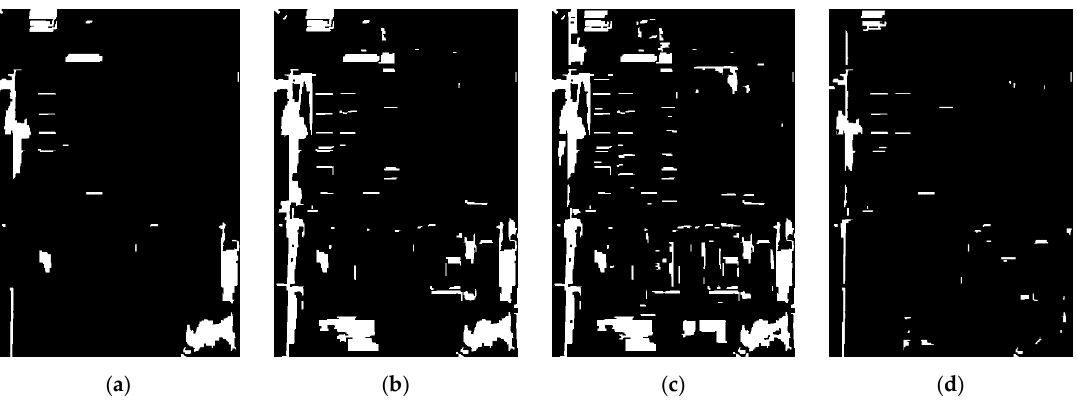
Figure 9. Object-based CD results based on segmentation maps for different Q values of ( a ) 32; ( b ) 64; ( c ) 128; ( d ) 256. Table 4. Accuracy of object-based CD results for different scale segmentation maps.